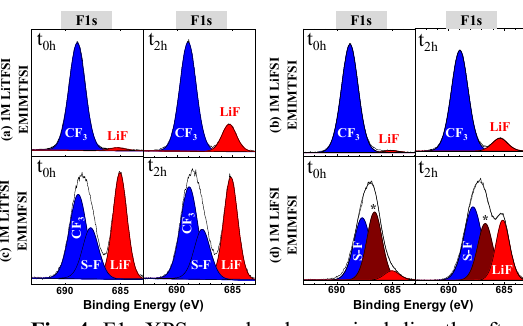
Fig. 4. F1s XPS core levels acquired directly after transfer (T 0h ) and after 2 hours (T 2h ) exposure to X-ray Al Kα for the electrolytes: (a) 1M LiTFSI in [EMIM + - TFSI - ], (b) 1M LiFSI in [EMIM + -TFSI - ], (c) 1M LiTFSI in [EMIM + -FSI - ] and (d) 1M LiFSI in [EMIM + -FSI -